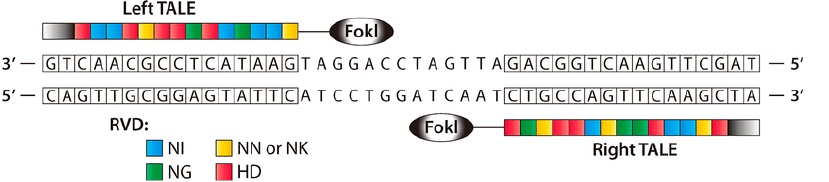
Figure 4. A TALEN dimer coupled with target DNA is shown schematically. To develop a modified nuclease that can detect unique left and right half-sites, TALE arrays are fused to the FokI nuclease domain. A spacer 12–20 bp in length separates the two TALE binding sites (reprinted with permission from [74]).